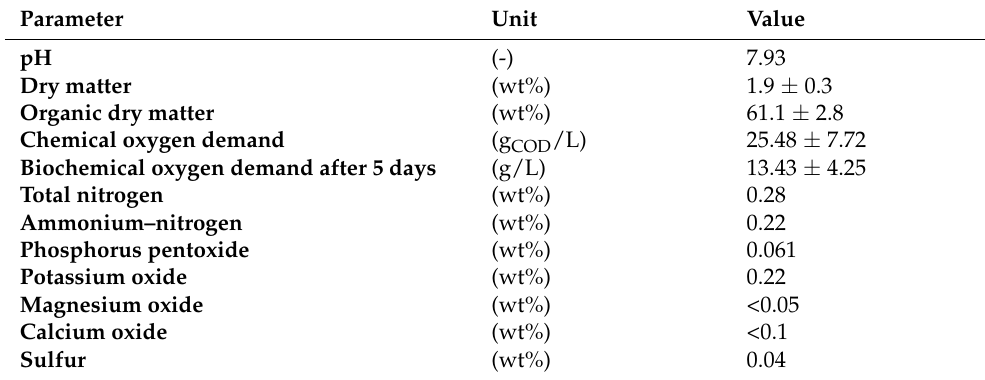
Table 1. Substrate properties of separated pig